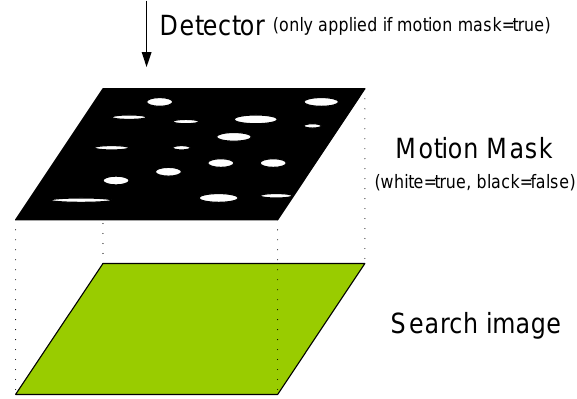
Figure 3: Functional description of the motion mask